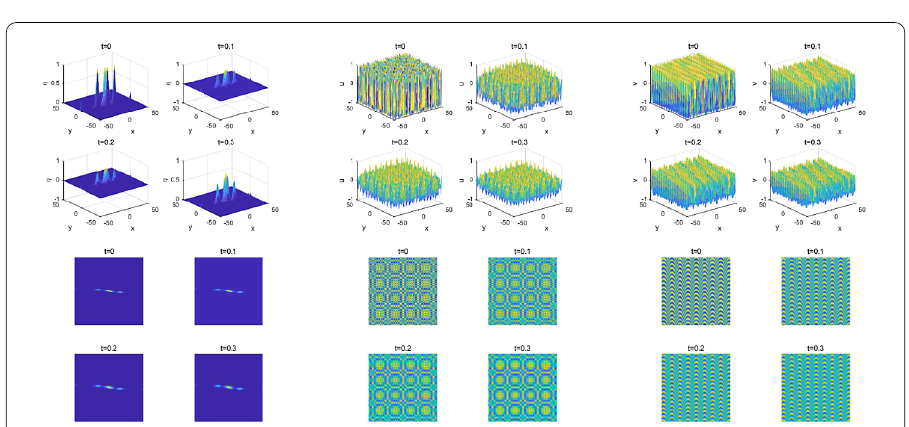
Figure 7 Numerical solution and pattern of Experiment 2, for initial conditions see Table